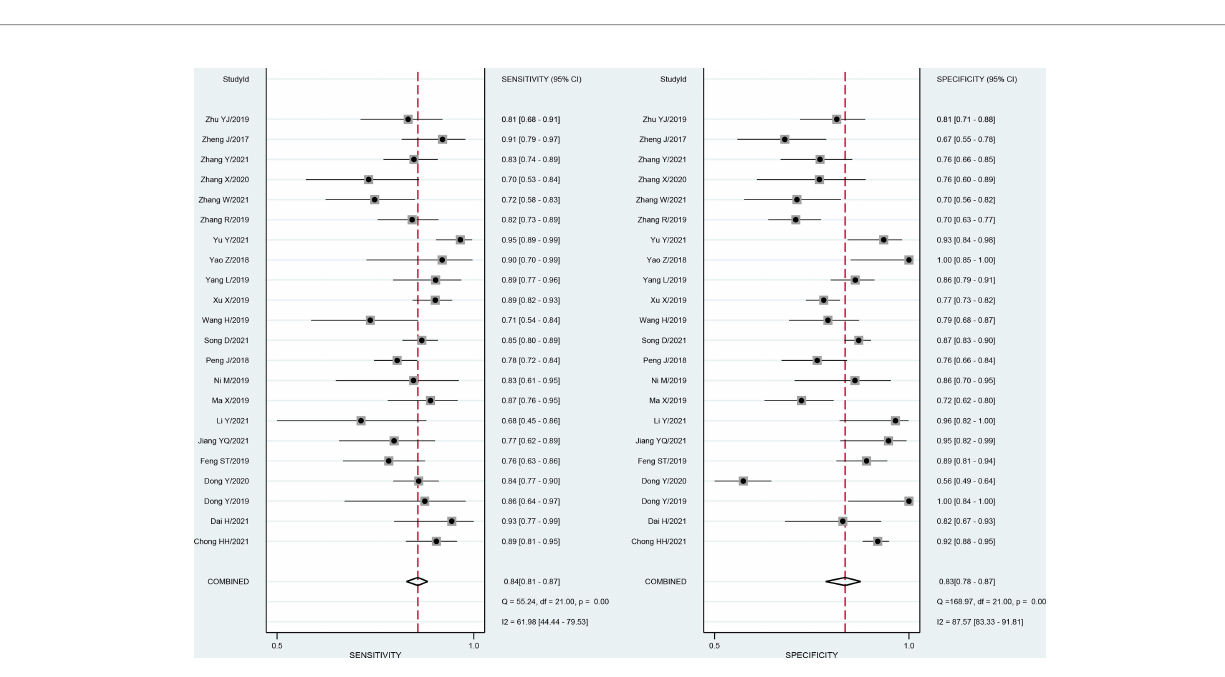
FIGURE 4 | Forest plots show the performance estimates (sensitivity and speci fi city) of each study based on radiomics for the preoperative prediction of MVI in HCC. Vertical lines in the forest plots show the pooled estimates of sensitivity and speci fi city. I 2 > 50% indicates substantial heterogeneity in the diagnostic parameters across